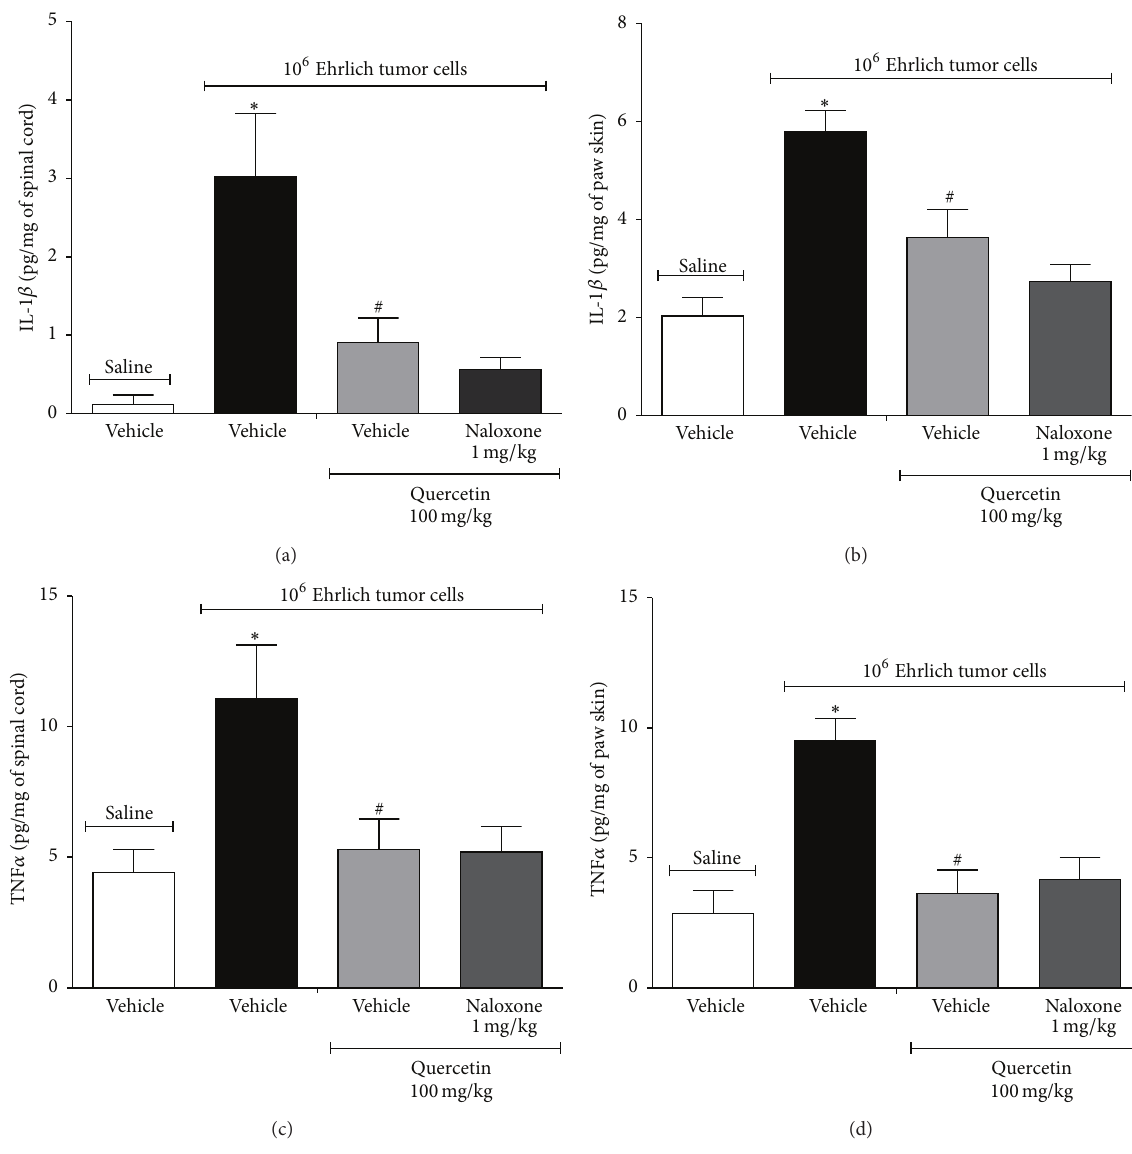
Figure 9: Naloxone did not reverse the effect of quercetin in reducing Ehrlich tumor cells-induced cytokine production. Mice were treated with quercetin (100mg/kg, i.p., starting 10min after tumor administration) during 8 days after the injection of Ehrlich tumor cells (1 × 10 6 or 1 × 10 7 cells/25 𝜇 L) or saline and, in the 8th day, one group of mice that received quercetin was also treated with naloxone (1mg/kg i.p. diluted in saline) or its vehicle 1h before the treatment with quercetin. IL-1 𝛽 concentration in spinal cord (a) or paw skin (b) and TNF 𝛼 concentration in spinal cord (c) or paw skin (d) were determined by ELISA 3h after the treatment with quercetin. Data are presented as means ± SEM of six mice per group per experiment and representative of two separated experiments: ∗ 𝑝 < 0.05 compared to the saline group and # 𝑝 < 0.05 compared to the tumor group. One-way ANOVA followed by Tukey’s